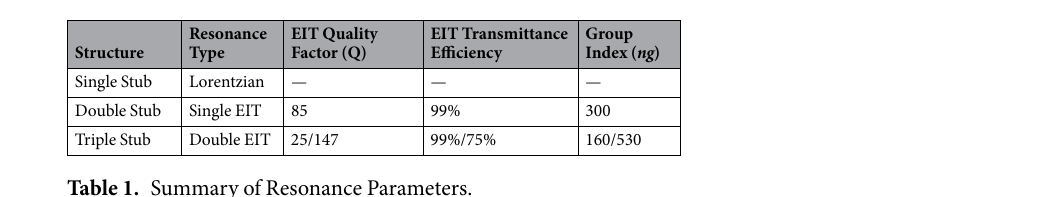
Table 1. Summary of Resonance